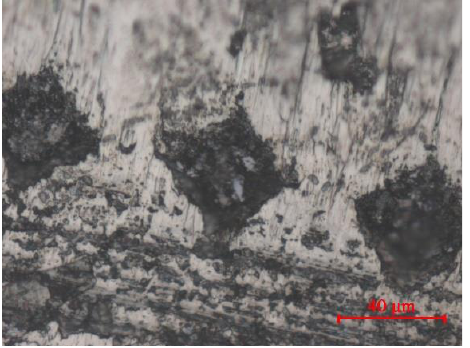
Figure 6. Grease residues inside the microtexture craters at the border of the growth zone; the build- up at V = 27 m/min, t = 0.5 mm, S = 0.15 mm/rev.